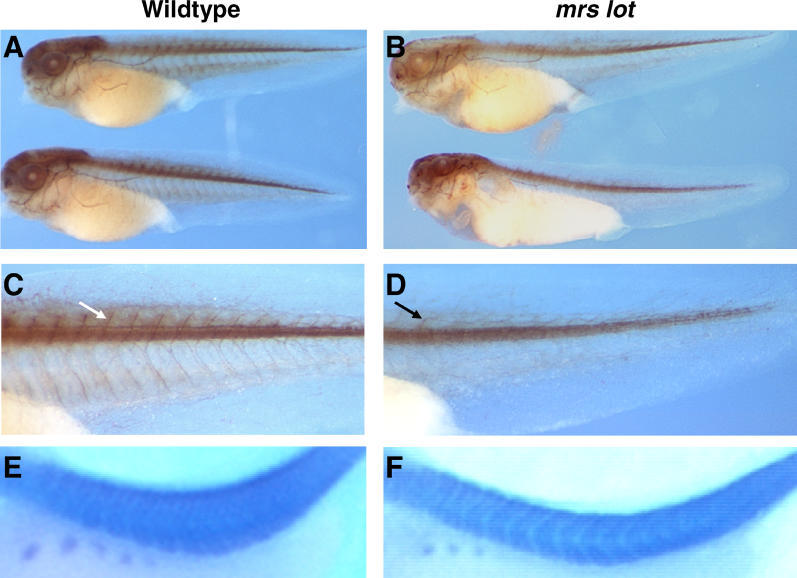
The mlo Mutation Exhibits Paralysis and Motor Neuron DefectsNeural tissue of mlo and diploid control was stained with the HNK-1 antibody. In wild-type tadpoles ([A] and [C]), motor neuron axons (white arrow) travel down the intermyotomal cleft from the neural tube; in mlo ([B] and [D]) the axonal tracts (black arrow) wander away from the intermyotomal space. In situ hybridization with cardiac actin ([E] and [F]) shows that somite structure is relatively unaffected.